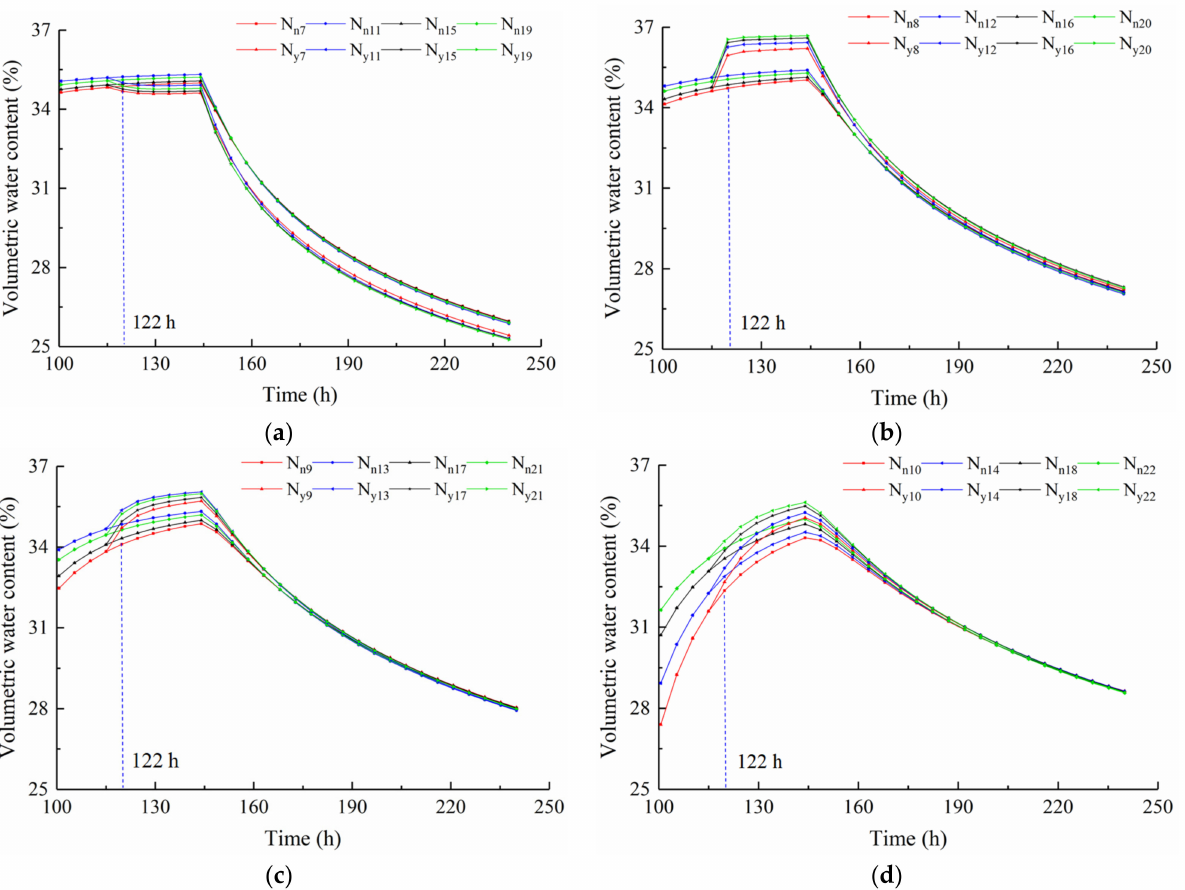
Figure 13. Curves of volumetric water content in additional monitoring points in the two numerical simulations: ( a ) upper points; ( b ) middle points; ( c ) lower points; ( d ) bottom points. According to the upper numerical monitoring points, the variation rule of volumetric water content of points (N n7 , N n11 , N n15 , and N n19 ) in NMOD was basically consistent with that of points (N y7 , N y11 , N y15 , and N y19 ) in NMODC (Figure 13a), but the volumetric water content in NMODC was slightly lower than that of corresponding points in